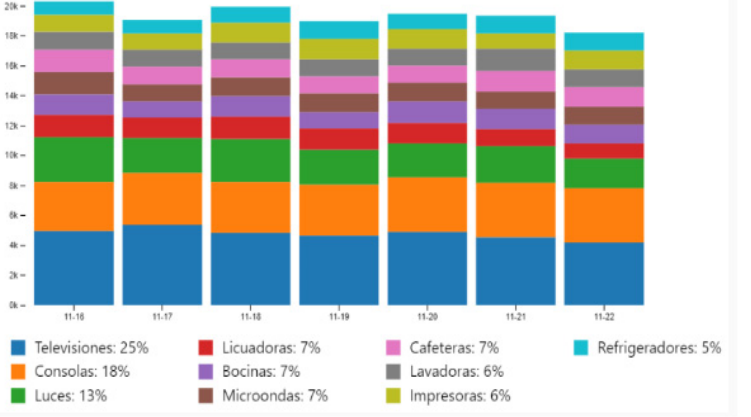
Figure 7. Consumption visualization: ( A ) Monthly consumption and the ( B ) scene consumption.